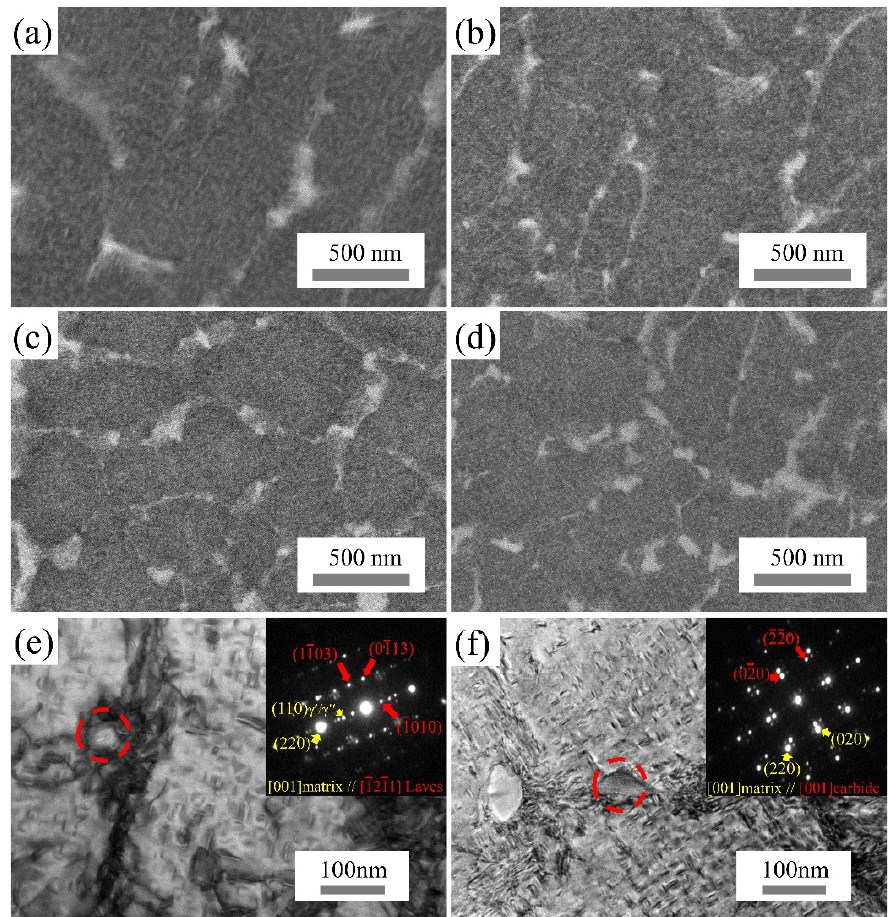
Figure 6. Microstructure of specimens after DA. ( a ) Without NbC, ( b ) 0.5% NbC, ( c ) 1.0% NbC, and ( d ) 5.0% NbC. ( e ) TEM bright field image of the specimen without NbC. diffraction pattern of hexagonal Laves phase. ( f ) TEM bright field image of particle in the specimen with 1% NbC. diffraction pattern of carbide particle. Table 4. Volume fractions and average diameters of Laves/carbide after different heat treatments.